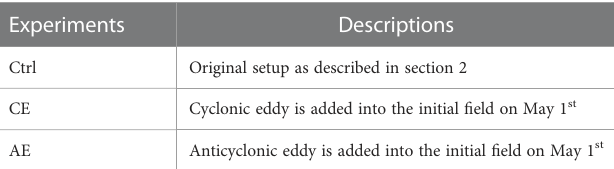
TABLE 1 Description of numerical experiments on the in fl uence of mesoscale eddies.